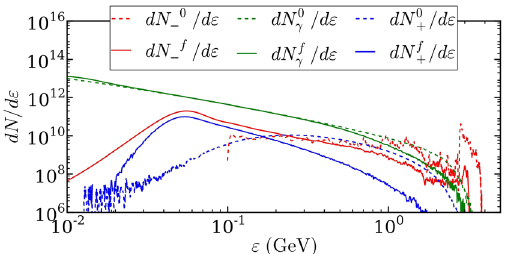
FIG. 8. Integrated energy spectra (in particles per GeV) of the electrons (red), photons (green) and positrons (blue). The solid lines( dN f =d ε ) correspond to the final spectra; the dashed lines ( dN 0 =d ε ) plot the electron beam spectrum before the laser interaction, and the photon and positron spectra at birth